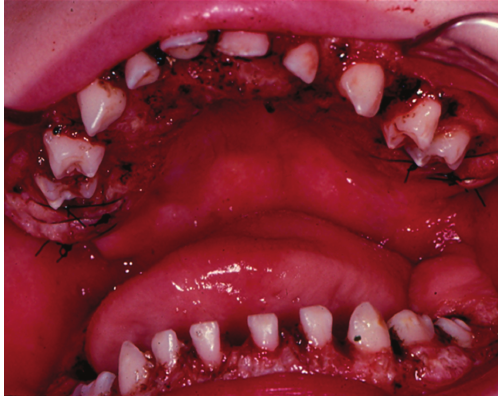
Figure 2: Immediate